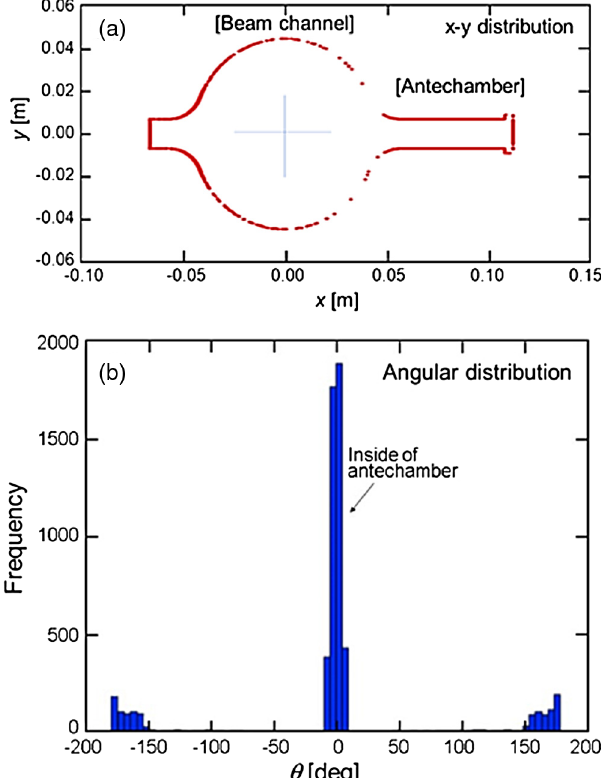
FIG. 15. (a) Positions of absorbed photons along the peripheral of the beam pipe, and (b) their angular distribution, where 0° corresponds to the inner most side of the antechamber, calculated by the simulation code S ynrad3 D